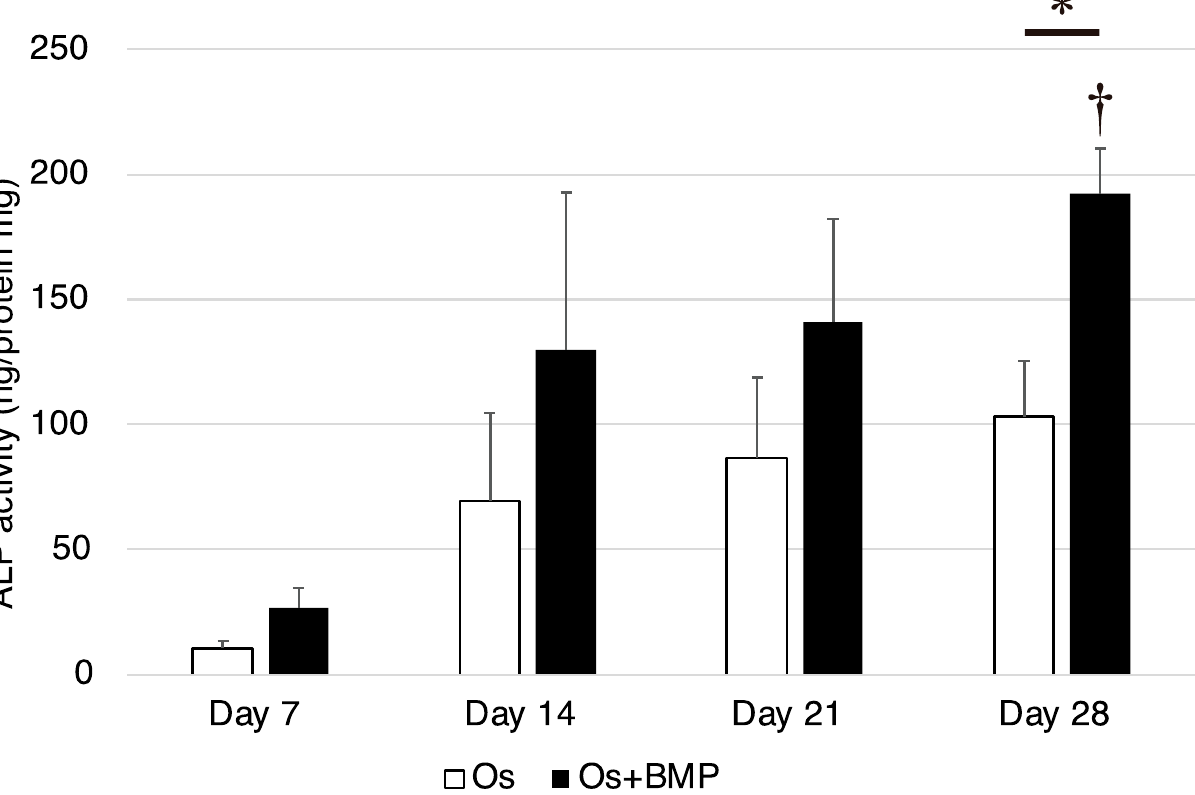
Figure 4. Analysis of the alkaline phosphatase (ALP) activity of non-hypertrophic nonunion cells (NHNCs). ALP activity of NHNCs in osteogenic medium (Os) and Os with E-BMP-2 (Os + BMP) on days 7, 14, 21, and 28. * p < 0.05 in the indicated group and † p < 0.05 compared with day 7 results in Os + BMP group.